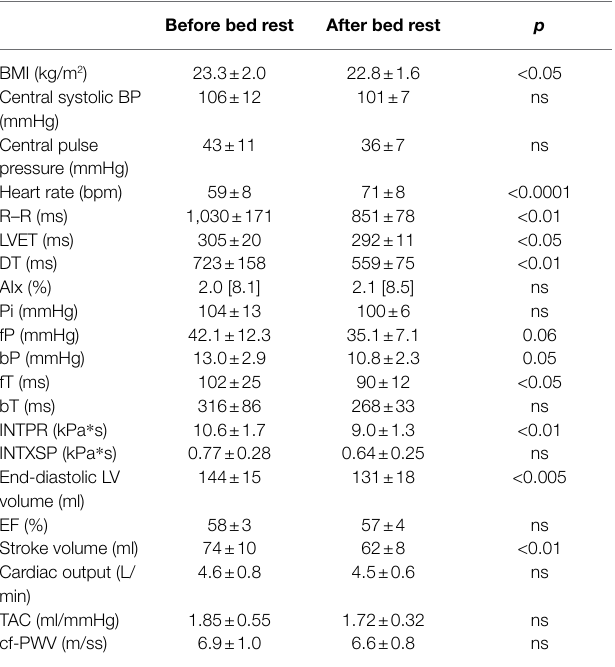
TABLE 1 | Haemodynamic data obtained by applanation tonometry, echocardiography and carotid–femoral pulse wave velocity measurements before and after the bed